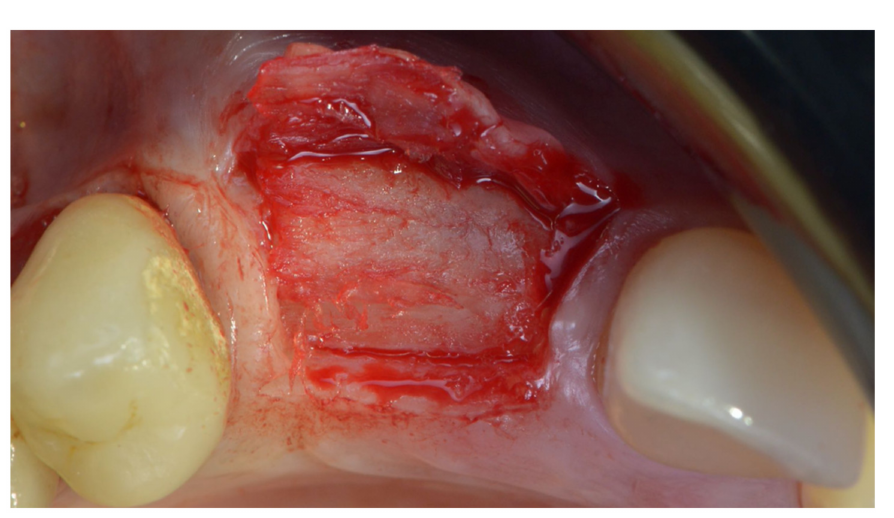
Figure 17. The bone lamina